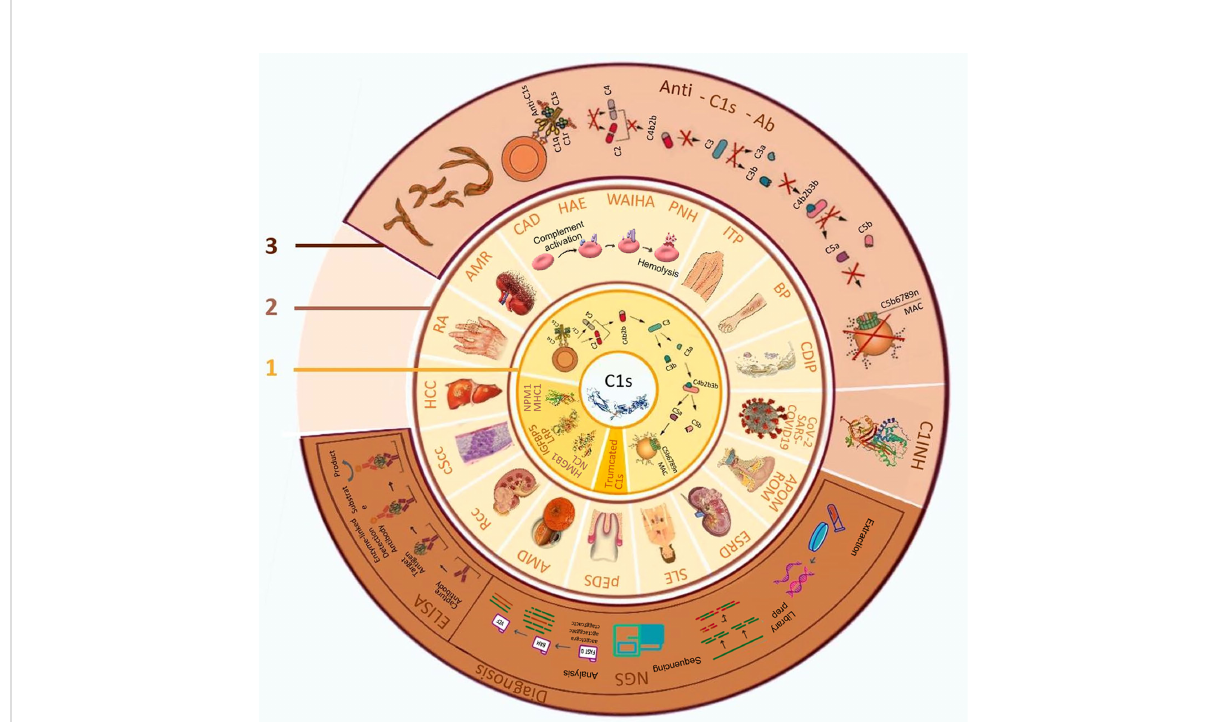
FIGURE 1 The biological function of C1s, related diseases and its application in diagnosis and treatment. 1. Biological functions of C1s; 2. C1s related diseases; 3. Application of C1s as a target in disease diagnosis and treatment. AMD: age-related macular degeneration; AMR: antibody-mediated rejection; APOM: acute pneumococcal otitis media; BP: bullous pemphigoid; CAD: cold agglutinin disease; CDIP: chronic in fl ammatory demyelinating polyradiculoneuropathy; COVID-19, coronavirus disease 2019; cScc: cutaneous squamous cell carcinoma cells; C1INH: C1 esterase inhibitors; ELISA, enzyme-linked immunosorbent assay; ESRD: end-stage renal disease; SLE: systemic lupus erythematosus; HAE: hereditary angioedema; HCC: hepatocellular carcinoma; HMGB1:high-mobility group box 1; IGFBP5: insulin-like growth factor binding protein- 5; ITP: idiopathic thrombocytopenic purpura; LRP: low-density lipoprotein receptor-related protein; MAC: membrane attacking complex; MHC1: Major histocompatibility complex 1; NCL: nucleolin; NGS, next-generation sequencing; NPM1: nucleophosmin 1; pEDS: periodontal ehlers-danlos syndrome; PNH: paroxysmal nocturnal haemoglobinuria; RA: rheumatoid arthritis; Rcc: renal cell carcinoma; ROM: recurrent otitis media; SARS-CoV-2, severe acute respiratory syndrome coronavirus 2; WAIHA: warm autoimmune hemolytic